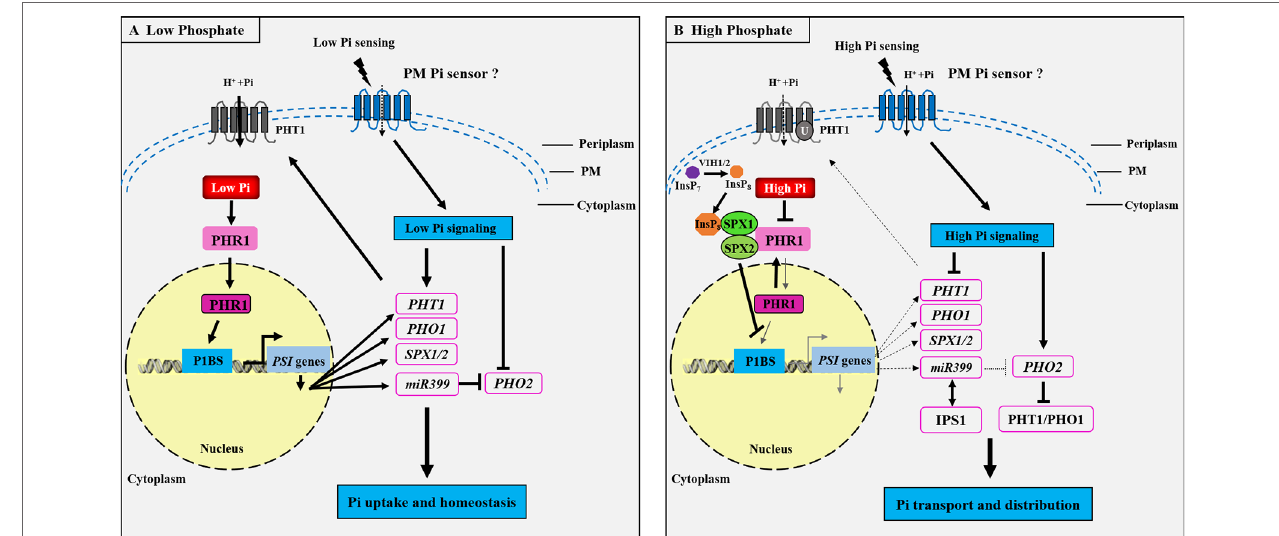
FIGURE 2 | Schematic representation of the phosphate (Pi) signaling pathway essential for plant adaptation to low Pi concentration. Under Pi deficiency (A) , a set of phosphate starvation-induced ( PSI ) genes are transcriptionally activated through binding of the transcription factor PHOSPHATE STARVATION RESPONSE 1 (PHR1) to the cis-element (P1BS) present in the promoter region of the PSI genes, and subsequently PHT1 and PHO1 mRNAs are induced to be necessary for Pi uptake and translocation in roots. The SPX1/2 and miR399 genes are also activated by PHR1 during Pi starvation. miR399 inhibits the ubiquitin E2 conjugase PHO2 in order to maintain the PHT1 protein activity at the PM. It could be proposed that the Pi signaling is activated for sensing external low Pi through an unknown PM Pi sensor, which induces the low Pi responsive genes PHT1 , PHO1 , SPX1/2 , and miR399 , whereas the PHO2 is repressed, thus activating the Pi regulatory pathway to modulate Pi uptake and homeostasis. Under high Pi concentration (B) , the Pi signaling pathway is repressed, the diphosphoinositol pentakisphosphate kinases VIH1 and VIH2 function redundantly to synthesize InsP 8 , and InsP 8 can directly bind to the SPX domain of SPX1 and is essential for the interaction between SPX1/2 and PHR1. This interaction leads to the inhibition of PHR1 binding to the cis -element P1BS present in the promoter region of the PSI genes. Thus, the PSI genes, including PHT1 , PHO1 , SPX1/2 , and miR399 , are transcriptionally repressed, while the PHO2 is activated to be responsible of the ubiquitination of PHT1 and PHO1 proteins to promote Pi transporters degradation. IPS1 encodes a non-coding RNA and enables post-transcriptional regulation under high Pi through RNA mimicry. IPS1-miR399 matching thus results in the inhibition of the miR399 activity to target PHO2. It is also predicted that there may exist an unknown PM Pi sensor responsible for high Pi sensing. PM, plasma membrane. The arrows and flat-ended lines refer to the positive and negative interactions, respectively. The dotted arrows represent the repression